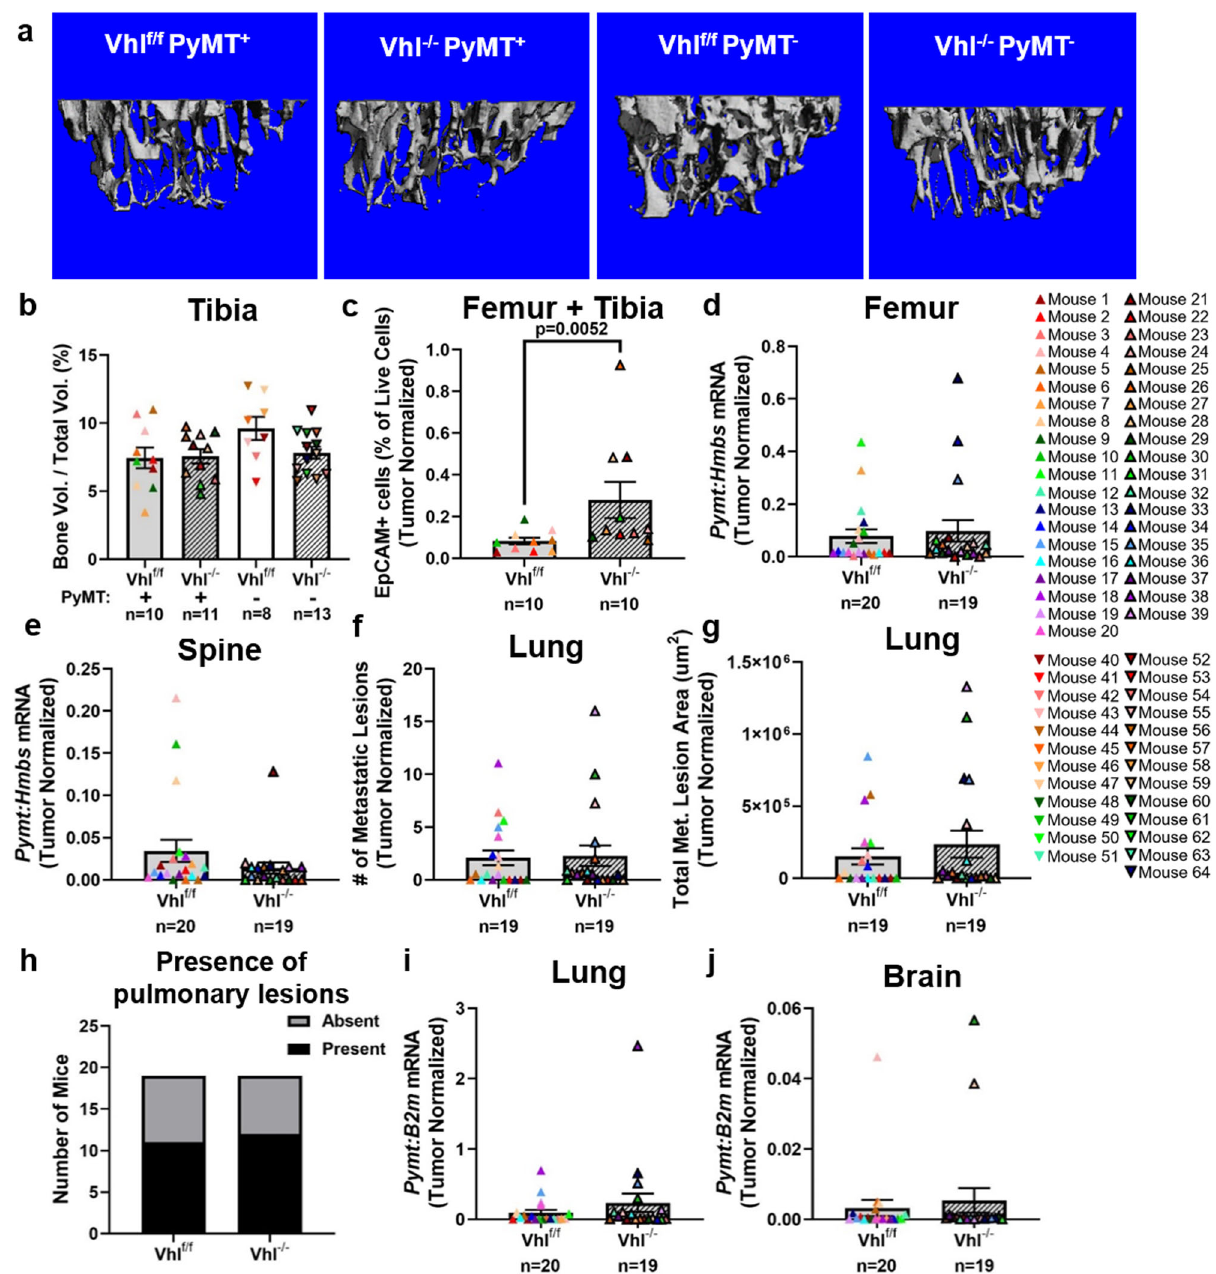
Fig. 7 Deletion of Vhl increases tumor dissemination to the bone but not to the lung. a Representative 3D renderings of microCT scans of the proximal metaphysis of the right tibia. b Quanti fi cation of bone volume from microCT analysis as a percentage of total volume. Two-tailed Mann – Whitney test against corresponding f/f control. n = 10 Vhl f/f PyMT + mouse tibiae, n = 11 Vhl − / − PyMT + mouse tibiae, n = 8 Vhl f/f PyMT − mouse tibiae, and n = 13 Vhl − / − PyMT − mouse tibiae. c The percentage of EpCAM + cells, out of the total number of live cells, detected by fl ow cytometric analysis of left hindlimb bone marrow. Values have been normalized to the total tumor burden at end point of each mouse. Two-tailed Mann – Whitney test. n = 10 Vhl f/f PyMT + mice, n = 10 Vhl − / − PyMT + mice. d , e Quantitative PCR analysis of Pymt transcript compared to Hmbs from right femur or spinal midsection, respectively. Values have been normalized to the total tumor burden at end point of each mouse. Two-tailed Mann – Whitney test. f , g Metastatic lesion number or area detected by histological analysis of H&E-stained sections from the left lung. Values have been normalized to the total tumor burden at end point of each mouse. Two-tailed Mann – Whitney test. h Comparison of the proportion of mice from each group that had any detectable pulmonary lesions. Fisher ’ s exact test. i , j Quantitative PCR analysis of Pymt transcript compared to B2m from the right lung or brain, respectively. Values have been normalized to the total tumor burden at end point of each mouse. Two-tailed Mann – Whitney test. Graphs represent mean per group and error bars represent s.e.m. For d – j , n = 20 (or 19 in f – h ) Vhl f/f PyMT + mice, n = 19 Vhl − / − PyMT +